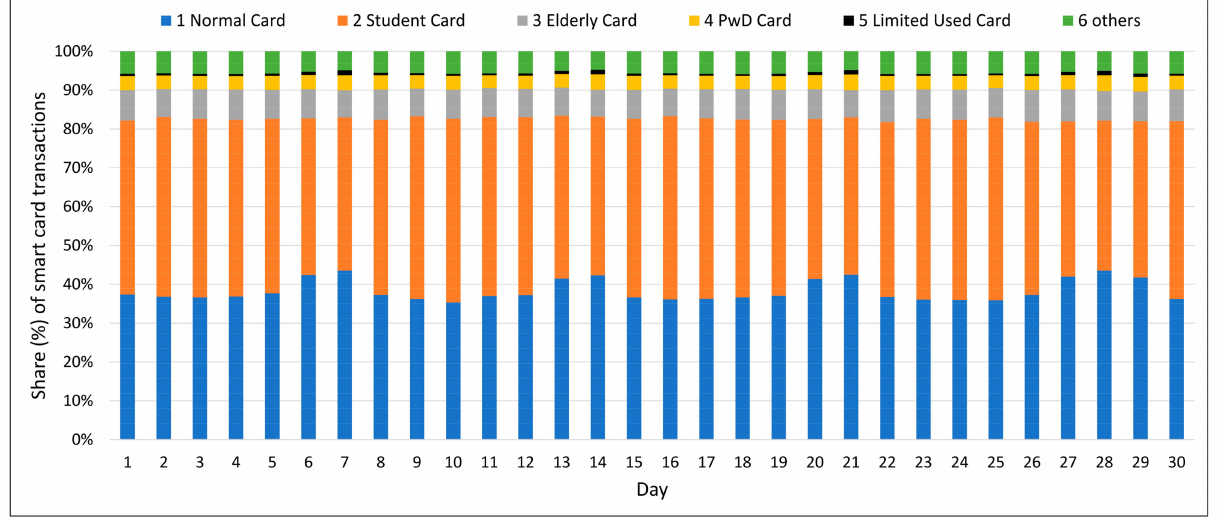
Figure 3. Distribution of boarding by different user groups. Table 3. The distribution of card holders in weekdays and weekend. Clustered User